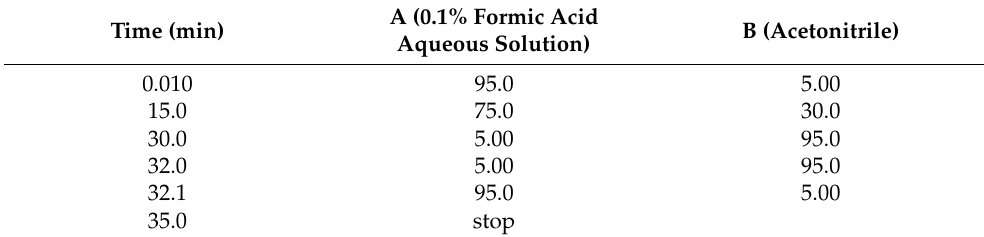
Table 1. The elution